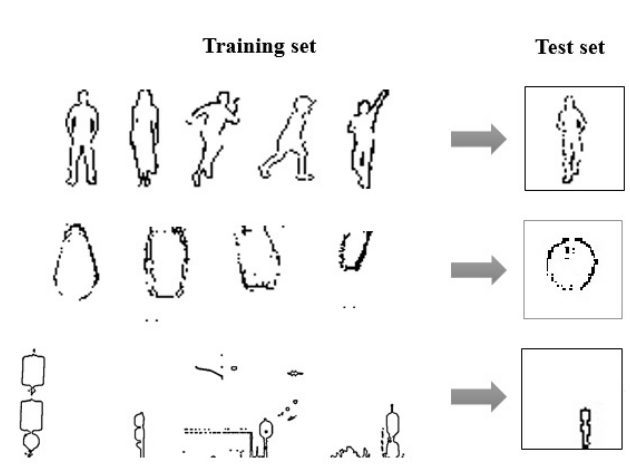
Fig. 12. Traffic light and wagon recognition experiment.